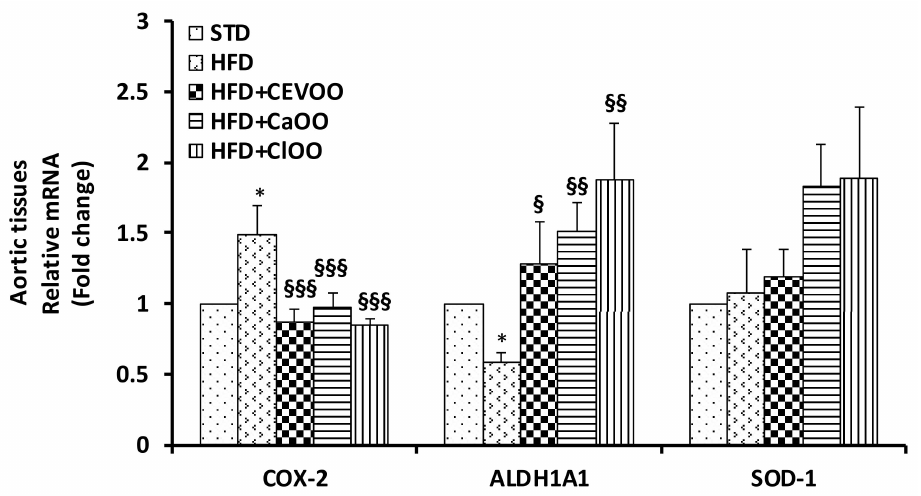
Figure 9. mRNA expression of COX-2, ALDH1A1 and SOD-1 in aortic vessel tissues of rats fed with HFD with / without CEVOO, Ca OO and Cl OO. Quantitative PCR analysis of COX-2, ALDH1A1 and SOD-1 in aortic vessel tissues. Data are reported as fold change expression, determined by the comparative C t method ( ∆∆ C t ) normalized to GAPDH expression, and are means ± standard deviation ( n = 3). Data as reported ad fold change vs. STD group which was assigned to 1; * p < 0.01 vs. STD; § p < 0.05, §§ p < 0.01, §§§ p < 0.001 vs.